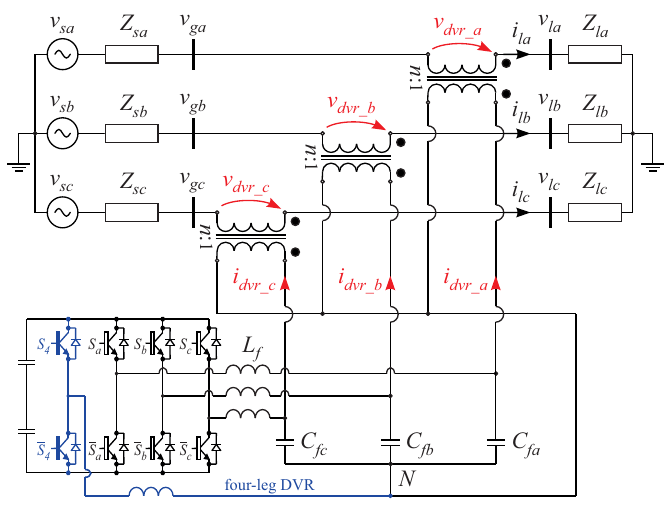
Figure 3. Three-phase circuit with a four-leg DVR